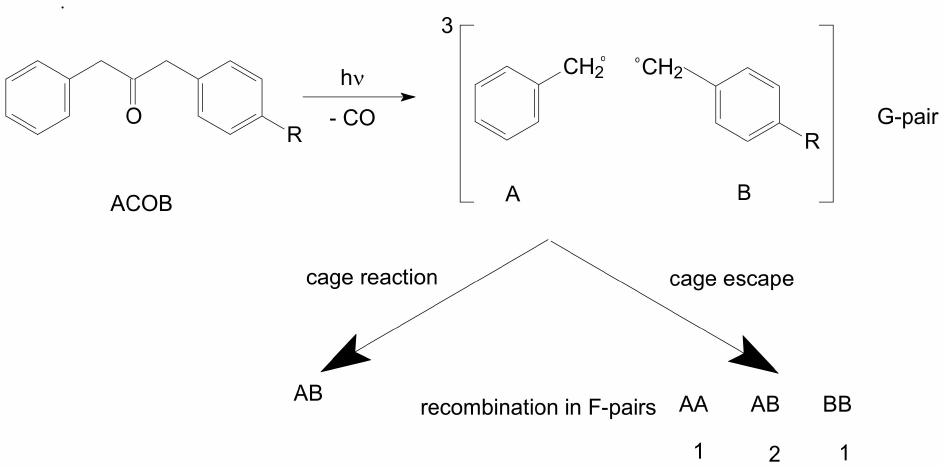
Scheme 2. Elementary chemical reactions during photolysis of substituted dibenzyl